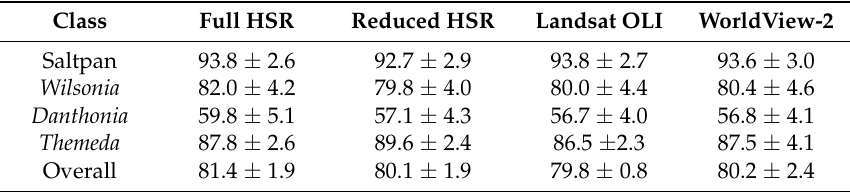
Table 5. Average RF classification accuracy and standard deviations for all four-class results, as averaged across the 30 RF classifications. Accuracies are presented as mean percentages, while standard deviation is presented as a percentage range above or below the